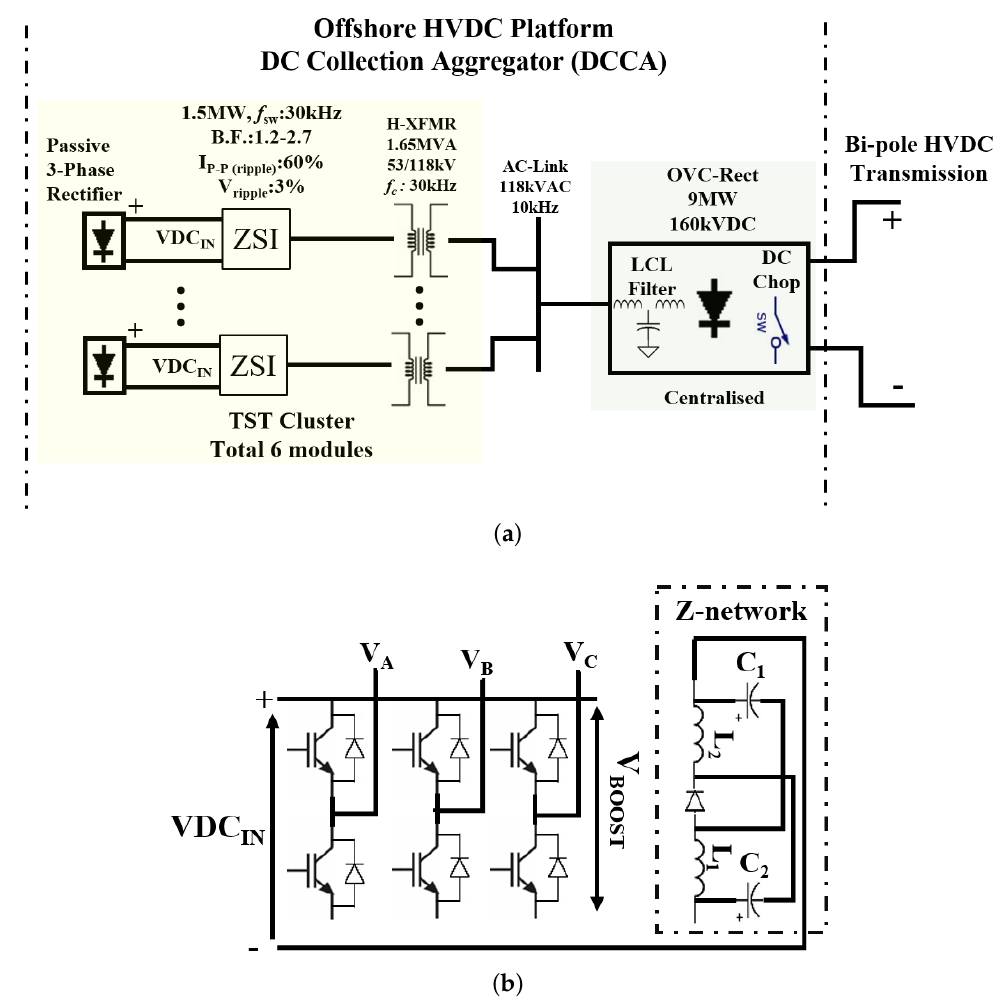
Figure 2. ( a ) single DCCA module serving six direct drive TSTs for tidal energy conversion system; ( b ) Impedance Source Inverter (ZSI) electrical